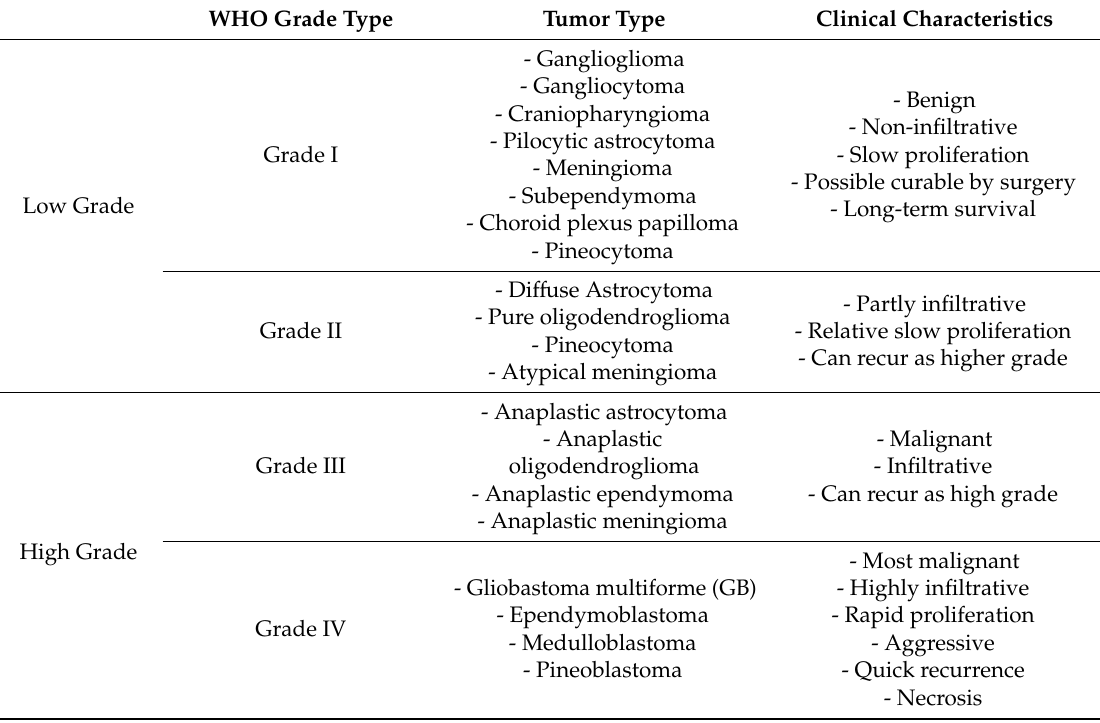
Table 1. Main clinical characteristics of selected CNS tumors with WHO grading